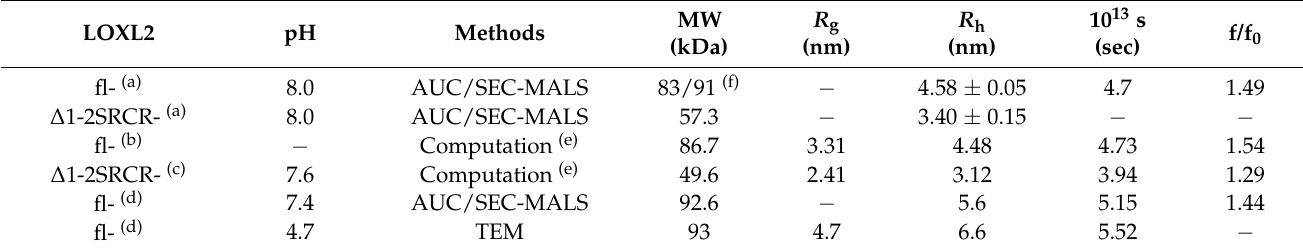
Table 1. A comparison of biophysical data of fl-LOXL2 and ∆ 1-2SRCR-LOXL2.